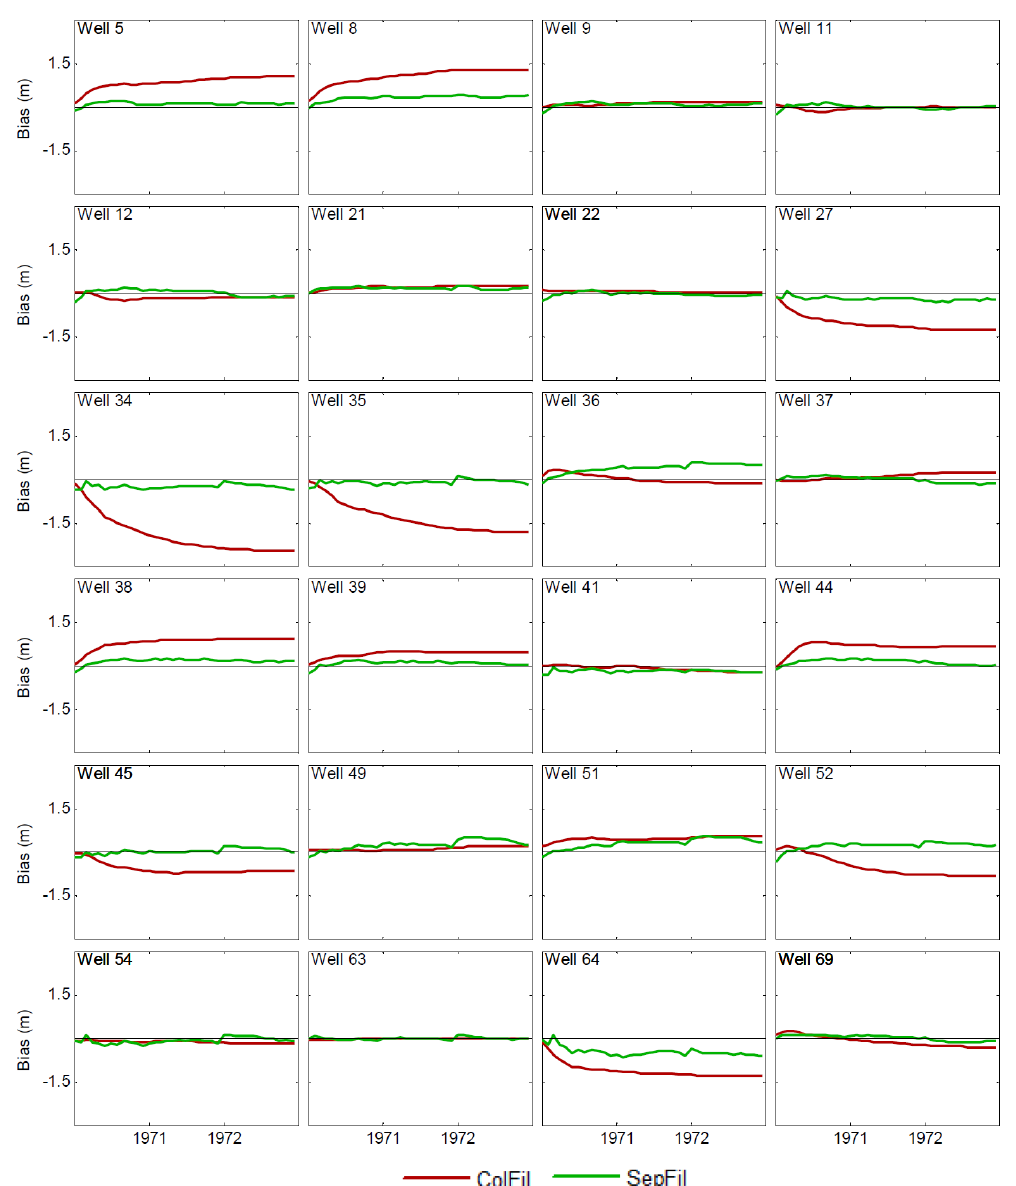
Figure 10. Estimated bias in the ColFilEns200 and SepFil scenarios as a function of time (real data). The black line indicates zero